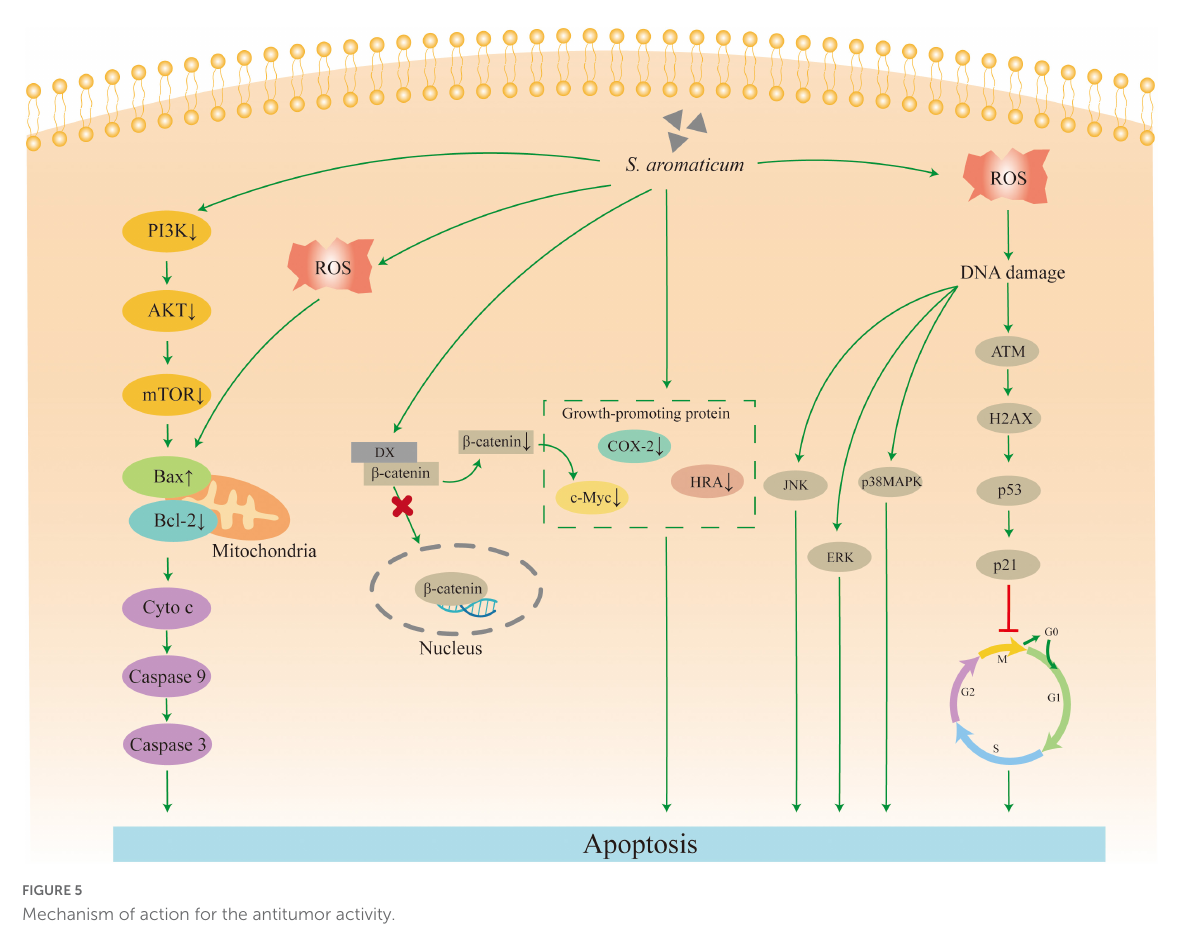
FIGURE5 Mechanism of action for the antitumor